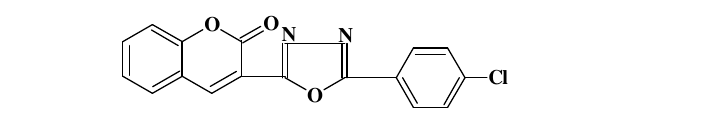
Figure 4. 2-(Chromen-3'-onyl)-5-(4"-chlorophenyl)-1,3,4-oxadiazole (L4); m.p.138º Synthesis of